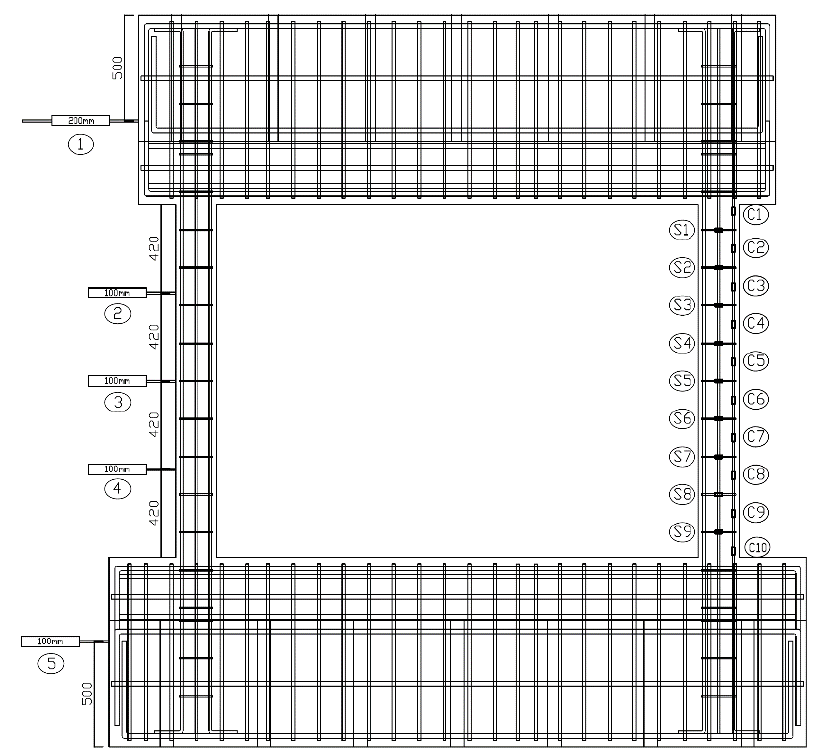
Figure 11. Measurement setup of LVDTs and strain gages.